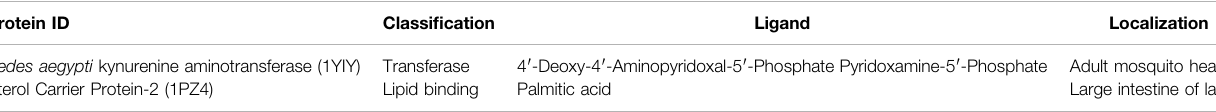
TABLE 1 | Information about the target proteins of Aedes aegypti and their respective ligand. Protein